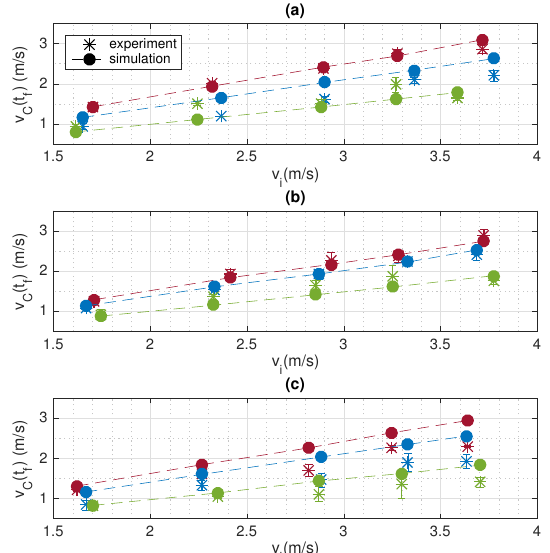
Figure 7. Mean experimental and simulated velocities of the center of mass after oblique impact on steel (red markers), concrete (blue markers) and asphalt (green markers) with impact angles ( a ) φ = 10 ◦ , ( b ) φ = 20 ◦ and ( c ) φ = 30 ◦ . Error bars indicate the standard deviations.